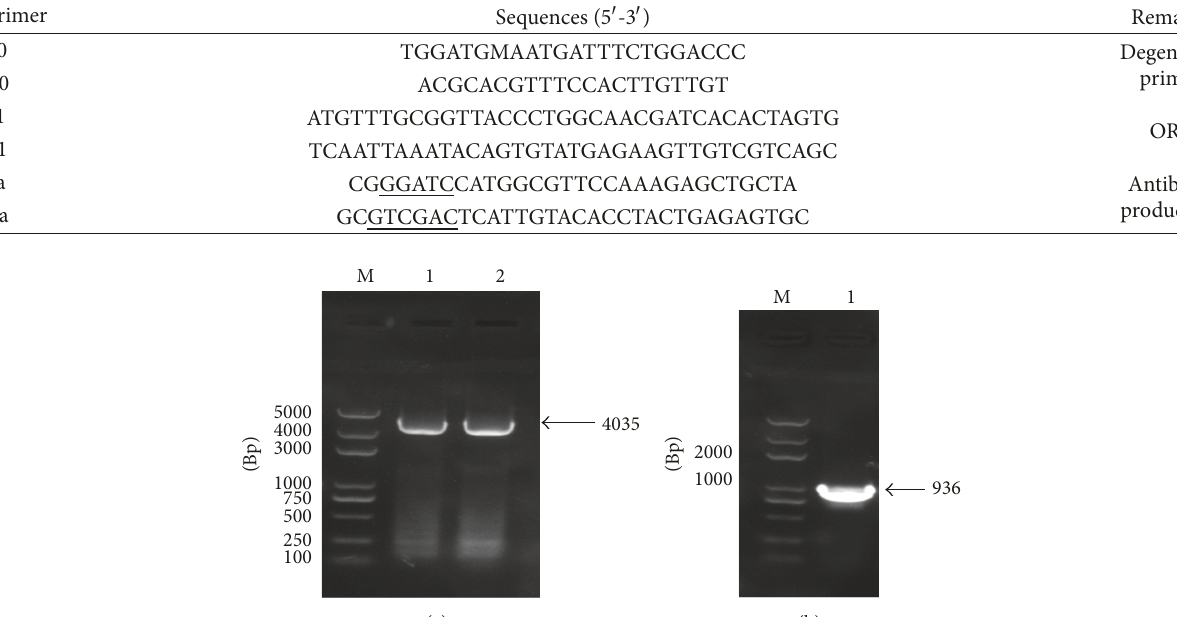
Table 2: Set of primers used for amplification in this work.